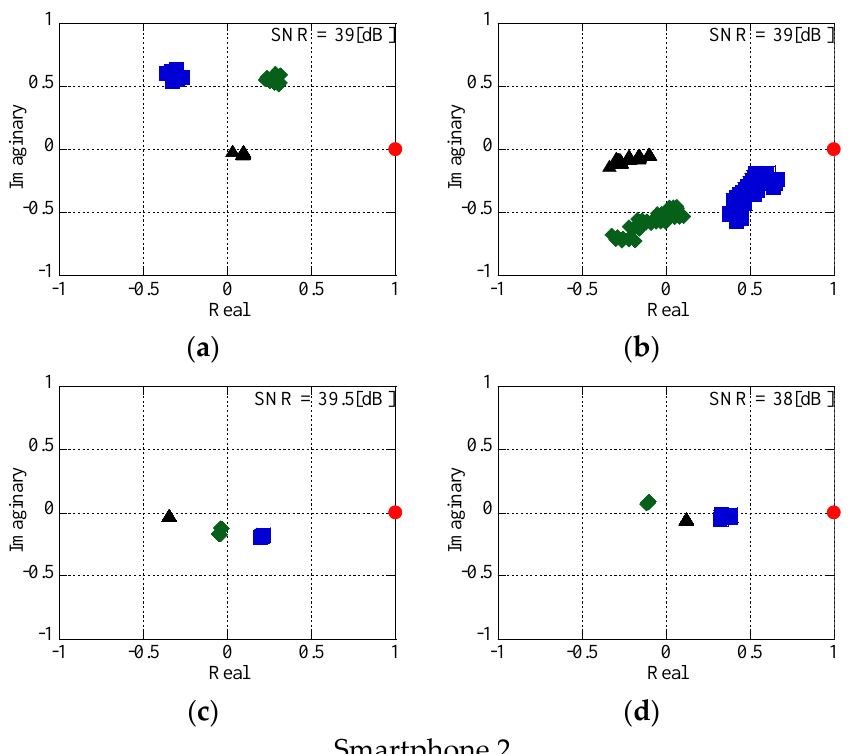
Figure 7. Channel matrix characteristic. ( a ) without human for Smartphone 1; ( b ) with human for Smartphone 1; ( c ) without human for Smartphone 2; ( d ) with human for Smartphone 2.